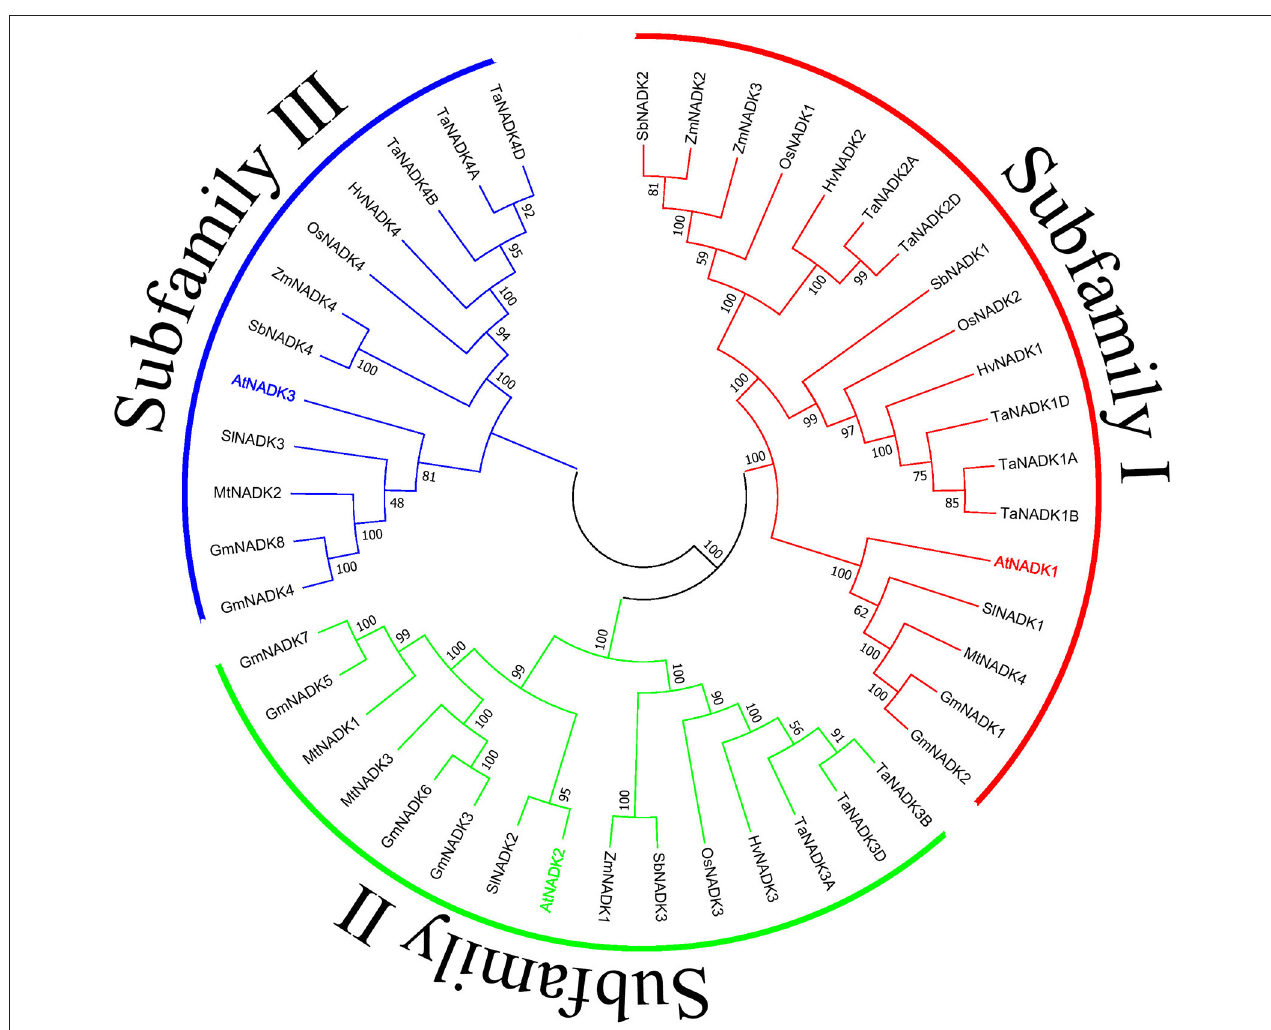
FIGURE 3 | Phylogenetic relationship of nine plant NADK families. The tree was constructed using the Neighbor-Joining method with the full length amino acid sequences of the NADKs from nine plant species. Numbers above the nodes represent bootstrap values from 1,000 replications. Subfamilies were divided as previously reported ( Li et al.,